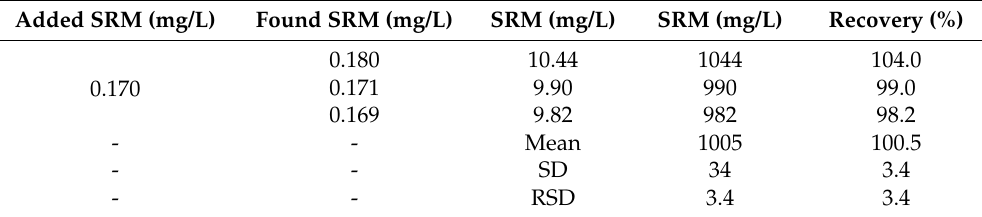
Table 6. Recovery of SRM (1000 mg/L ± 3 mg/L) spiked to tap